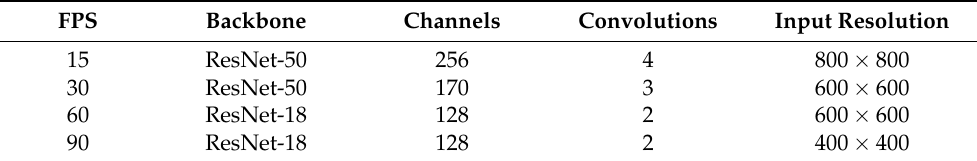
Figure 6. Comparison of different classification head settings, i.e., number of stacked convolutions and number of channels, for input images of size 800 × 800 (left), 600 × 600 (middle) and 400 × 400 (right). Reducing the resolution to 600 × 600 impairs the precision only slightly while the accuracy is significantly increased. Further reducing it to 400 × 400 decreases the precision heavily for large model configurations. However, for small model configurations the relative impairment is lower while still significantly increasing the frame rate. Thus, both steps are considered for selecting the final models. Table 12. Selected model configuration for each of the four targeted frame rates. Channels are the number of channels in the neck and in the head. Convolutions are the number of stacked convolutions in the head. For each targeted frame rate the most precise configuration is selected from Figure